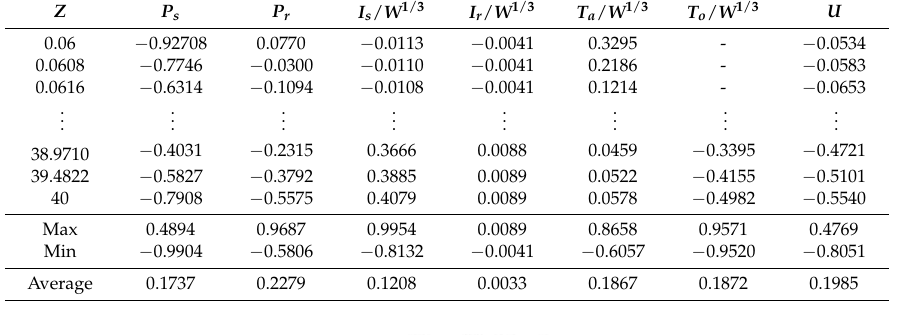
Table 6. Error of Modified Equation for Surface Burst (Unit: %).